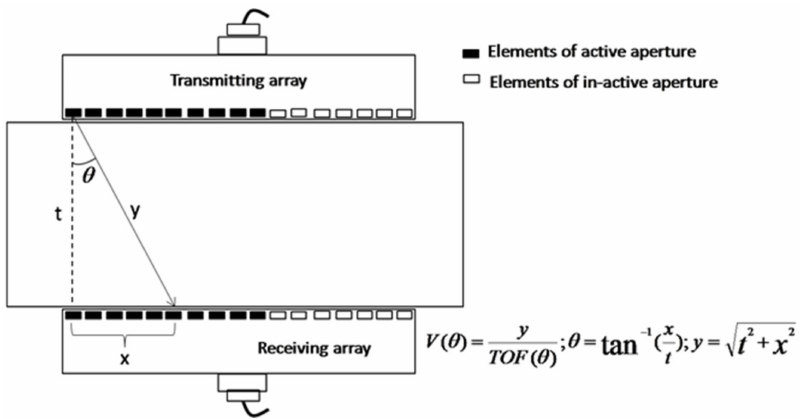
Figure 2. Schematic showing the phased array trough-transmission (TT) setup used for measuring angle-dependent anisotropic ultrasonic velocity.